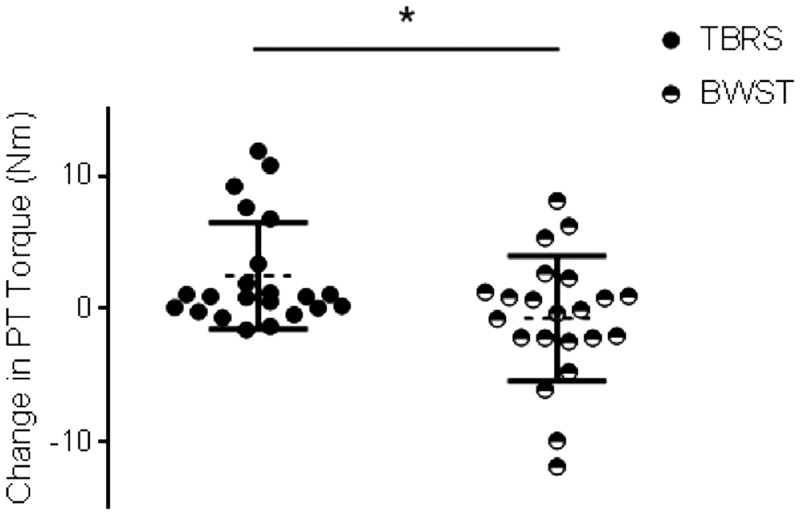
Figure 4. Exercise modality effects on evoked contractile properties. Change in peak twitch (PT) in body-weight support treadmill (BWST) (black/white circle) and total-body recumbent stepper (TBRS) (black circle) collapsed across temperature conditions. *Indicates a significant (p<0.05) main effect of exercise modality.